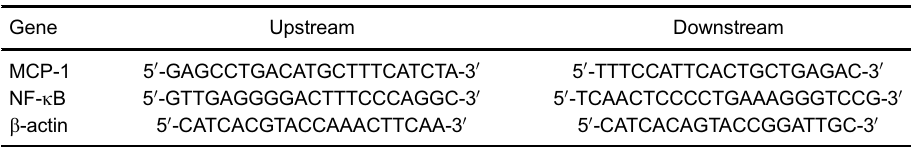
Table 1. Primer sequences of MCP-1and NF- k B. Gene Upstream